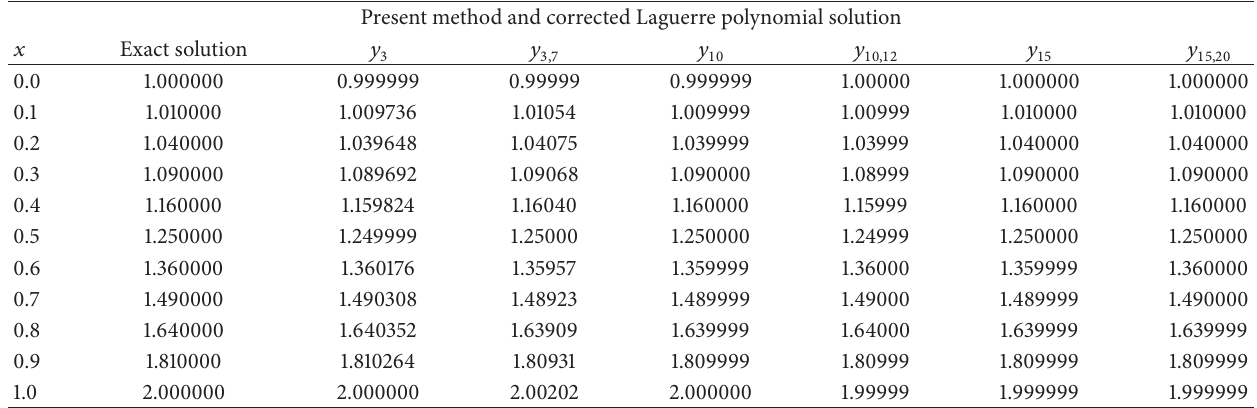
Table 1: Numerical solution of Example 4 for different 𝑁 values.